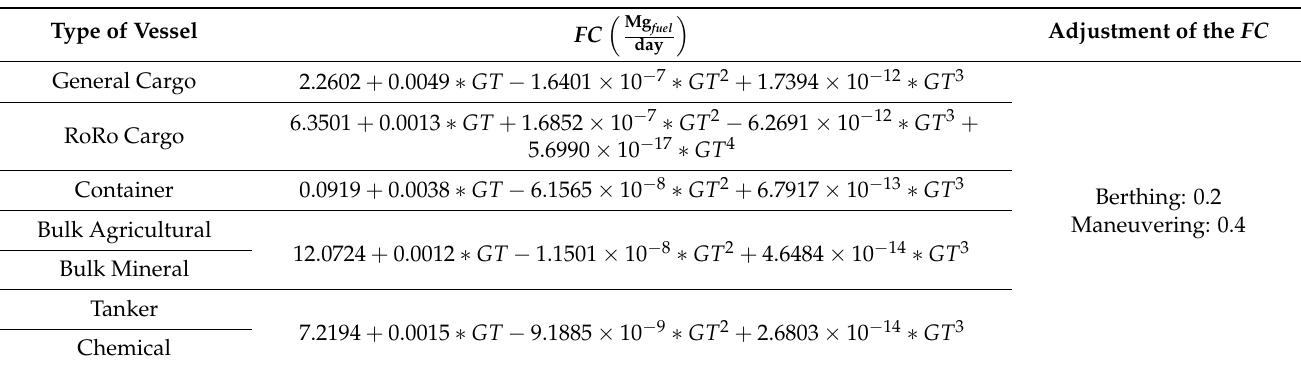
Adjustment of the